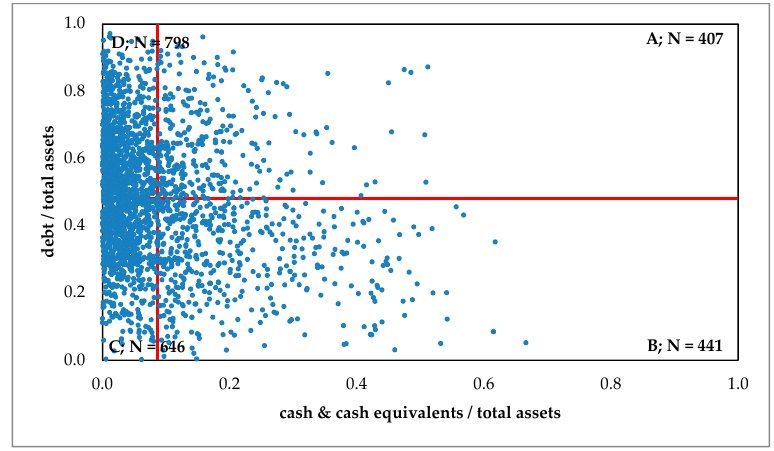
Figure 2. Dispersion of debt capacity constraint (debt to total assets) and liquidity constraint (cash and cash equivalents to total assets) in the examined sample (N = 2292). Red lines reflect the mean values.